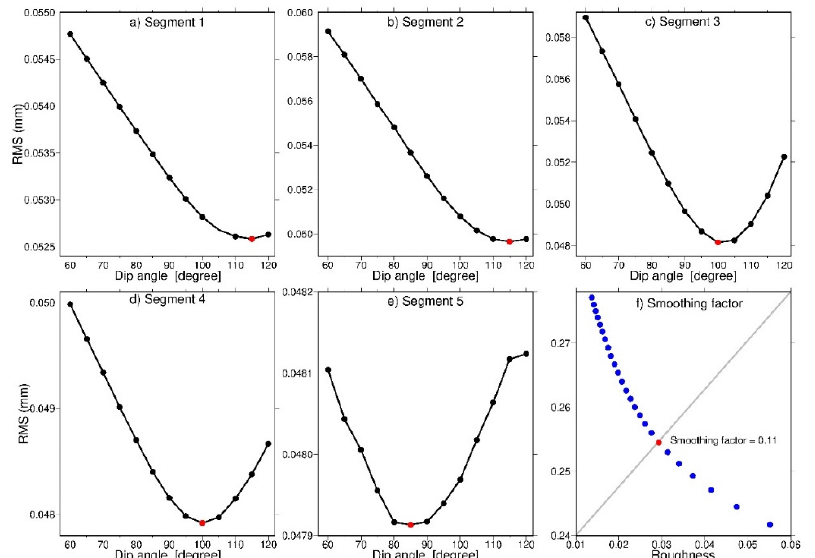
Figure 4. ( a – e ) Trade-off curve between root-mean-square (RMS) misfit and dip angle for five fault segments in the slip model. The red point indicates the best-fitting dip angle used to invert the coseismic slip distribution shown in Figure 5. ( f ) Trade-off curve with model roughness plotted as a function of RMS misfit. The red dot is the preferred smoothing factor (0.11) used in our coseismic slip distribution inversion.